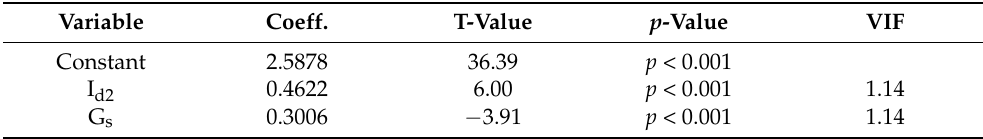
Table 3. MLR Parameter